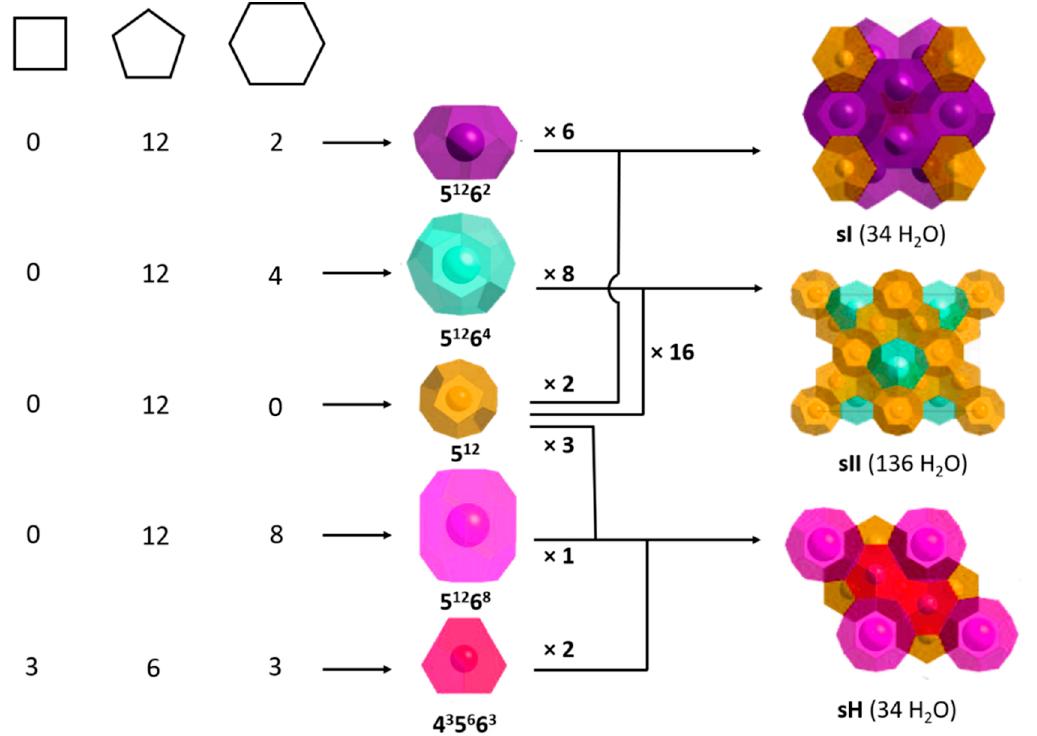
Figure 1. Schematic of sI and sII polymorphs with host lattice shown in terms of 5 12 , 5 12 6 2 and 5 12 6 4 cages. In sI, two small 5 12 pentagonal dodecahedral cavities and six larger tetrakaidecahedral 5 12 6 2 cages define the unit cell of 46 water molecules. For sII, each unit cell contains 136 water molecules and 24 cages: 16 small 5 12 pentagonal dodecahedral cavities and 8 larger 5 12 6 4